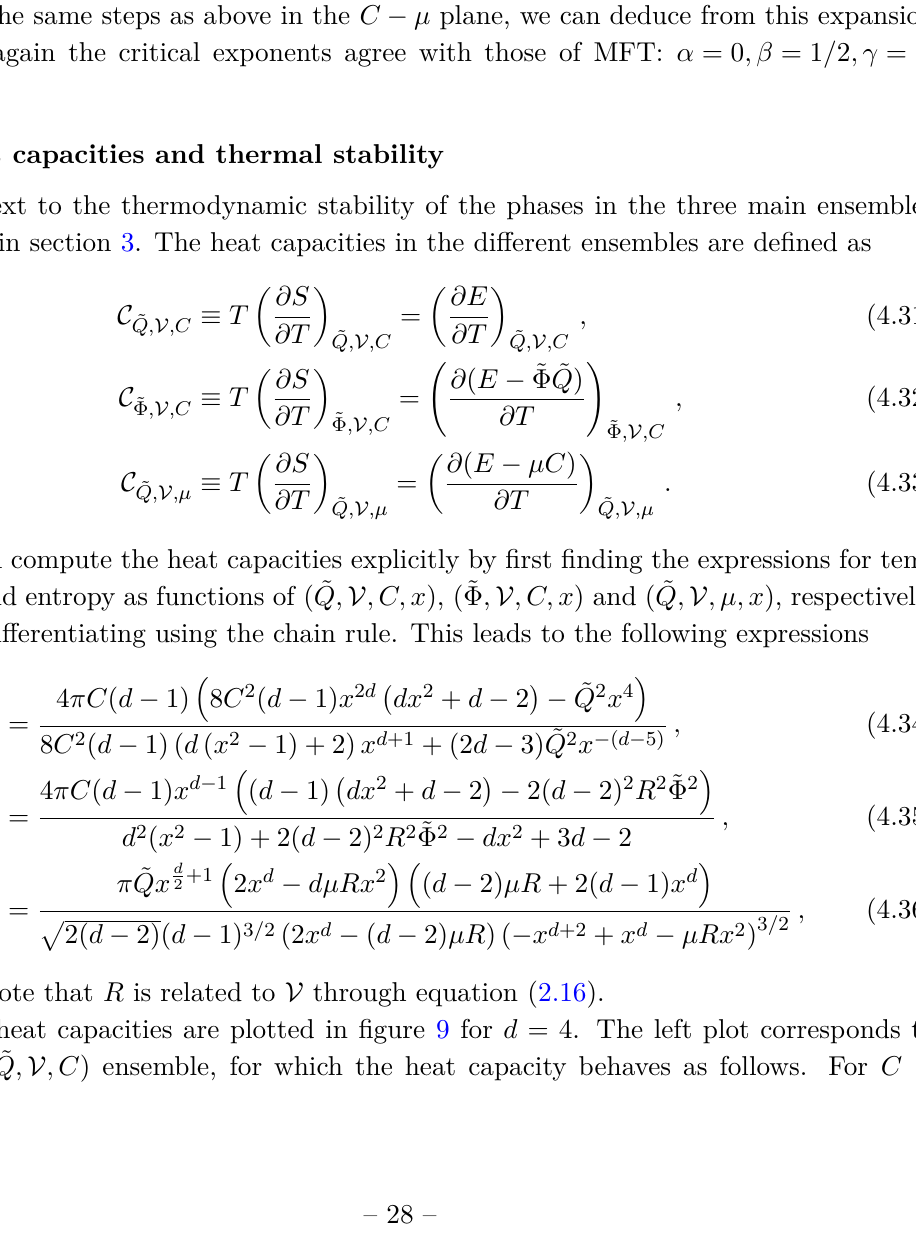
Figure 9 . Heat capacities, from left to right, for fixed ( in d = 4 . For ease of comparison, the parameters used here are the same as in figures 1, 2 and 3,